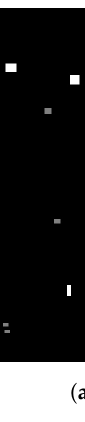
Figure 2. Ground Truth. ( a ) Selected ROIs in the pre-event image; ( b ) Updated flooding ground truth in the post-event image [15].